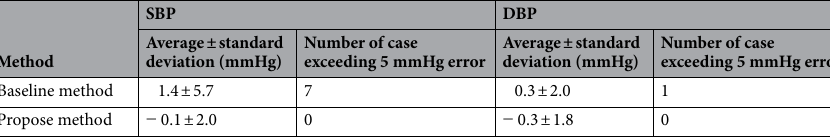
Table 4. Prediction errors for low SNR signals.